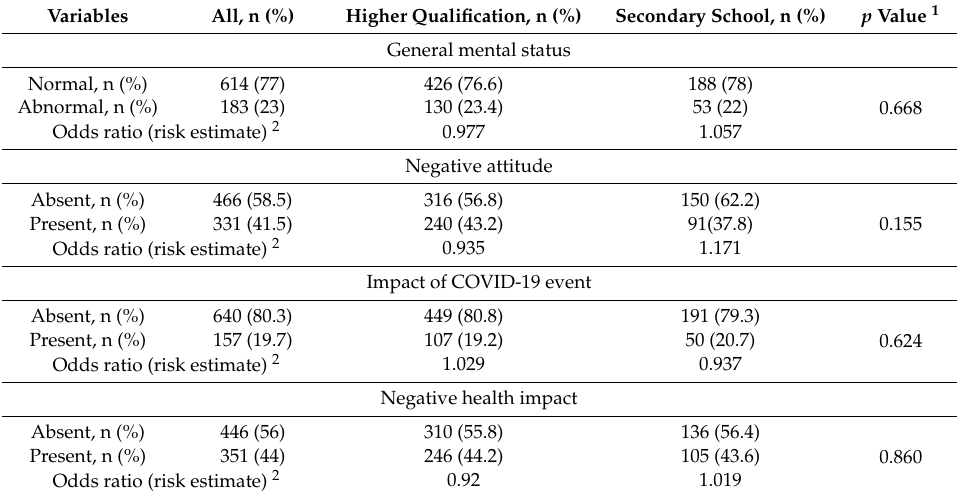
Table 4. General mental status, negative attitude, IES, negative health impact by educational level.